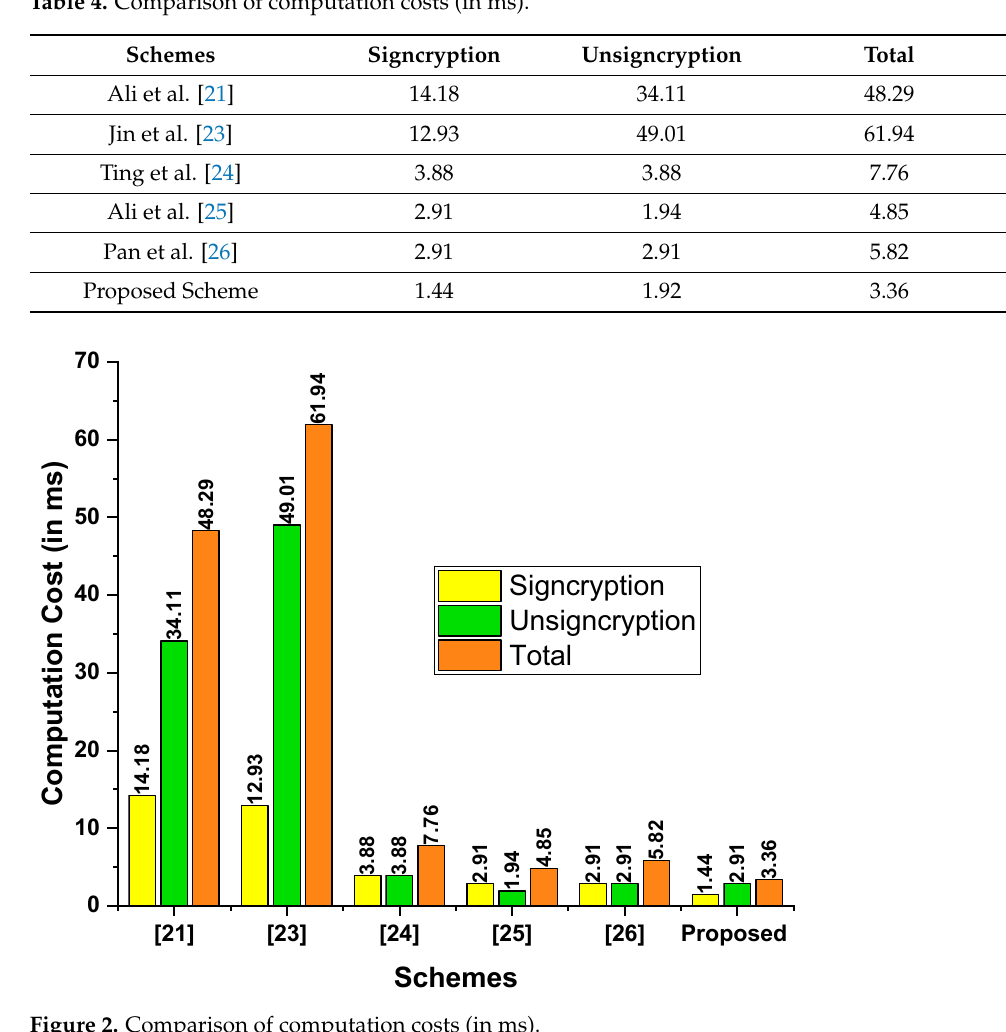
Figure 2. Comparison of computation costs (in ms). Table 4. Comparison of computation costs (in ms).